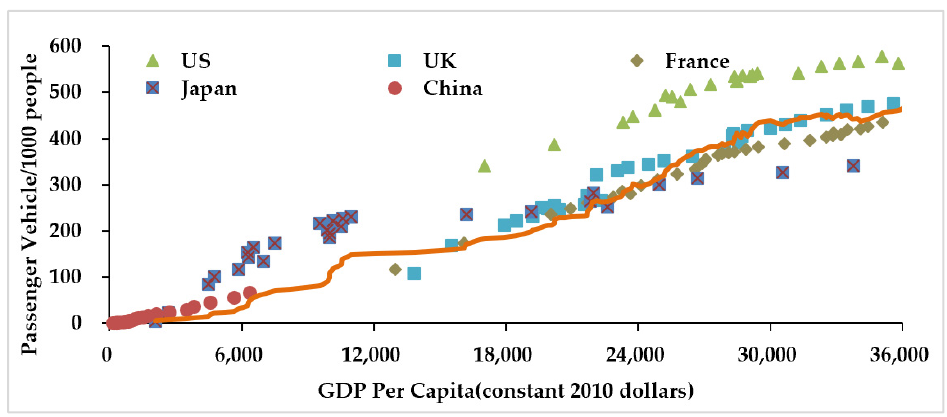
Figure 1. Passenger vehicle ownership per 1000 people in developed countries and China. The data of GDP and population from World Bank Open Data; passenger vehicle ownership from World Motor Vehicle Statistics (2016).